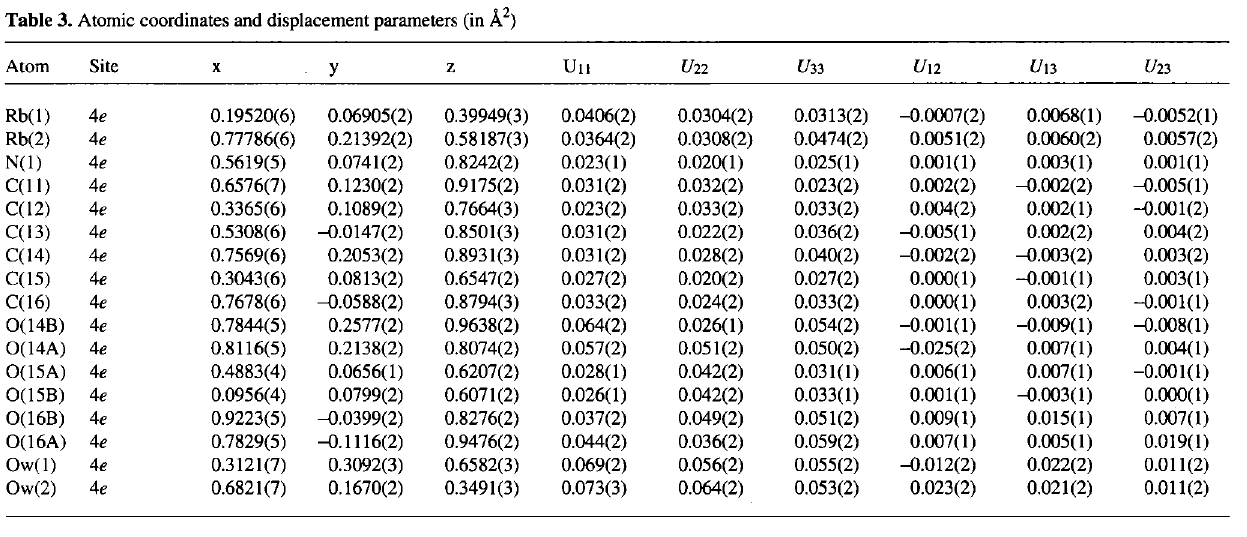
Table 3. Atomic coordinates and displacement parameters (in Â 2